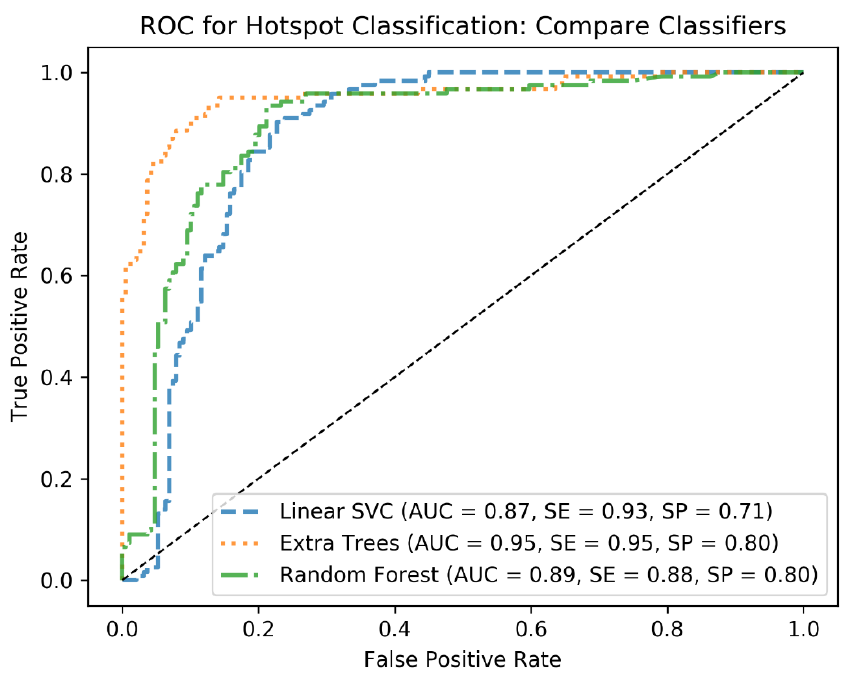
Figure 2. The receiver operating characteristic (ROC) curves to compare three classifiers. The classifiers are ranked after tuning in the cross-validation step and trained with the first training cohort with 30 subjects and then applied to the test cohort. Table 5. The mean and standard deviation (std) values of the area under the curves (AUCs), sensitivities, and specificities achieved as the training cohort was extended.